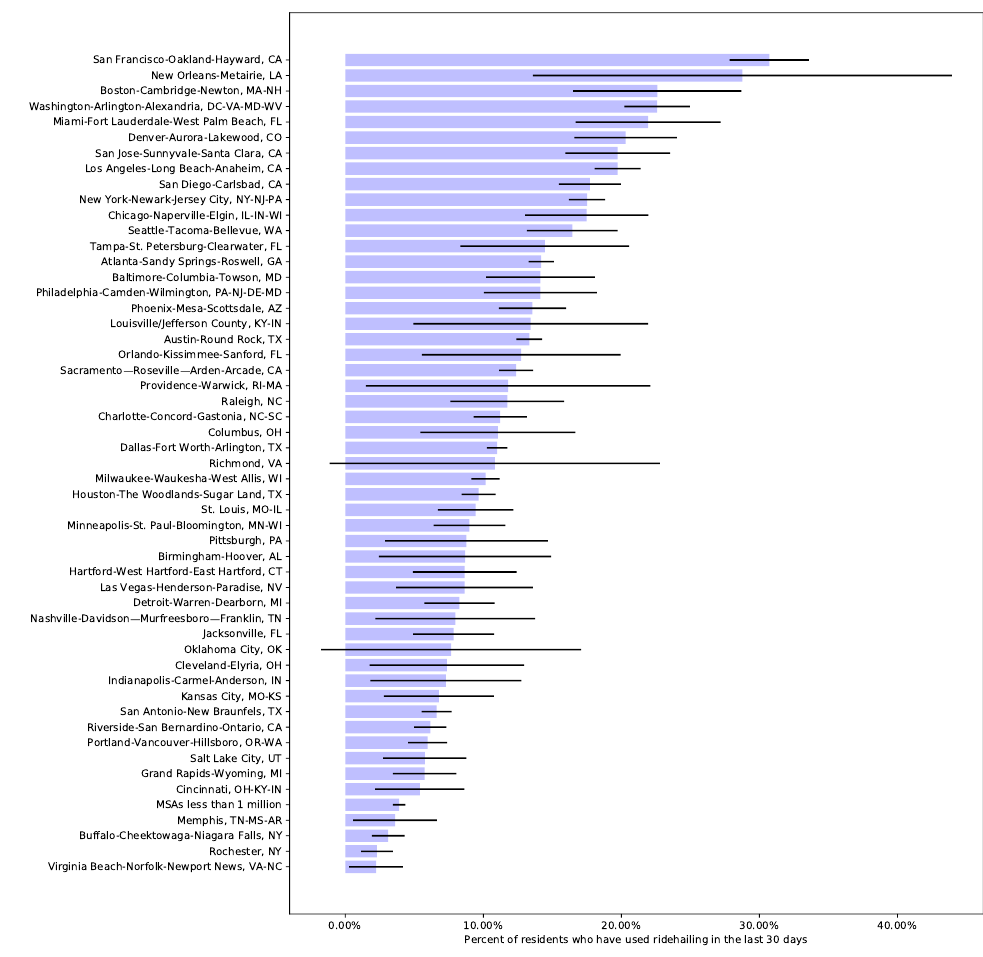
Figure 3. Per capita use of ridehailing services, by geography (black lines indicate 95% confidence intervals). Table 1. Ridehailing use by demographic subgroups (margins of error indicate 95% confidence intervals). Percentage Who Have Used Average Number of Ridehailing Trips Ridehailing in the Last 30 Days in the Last 30 Days for Ridehailing